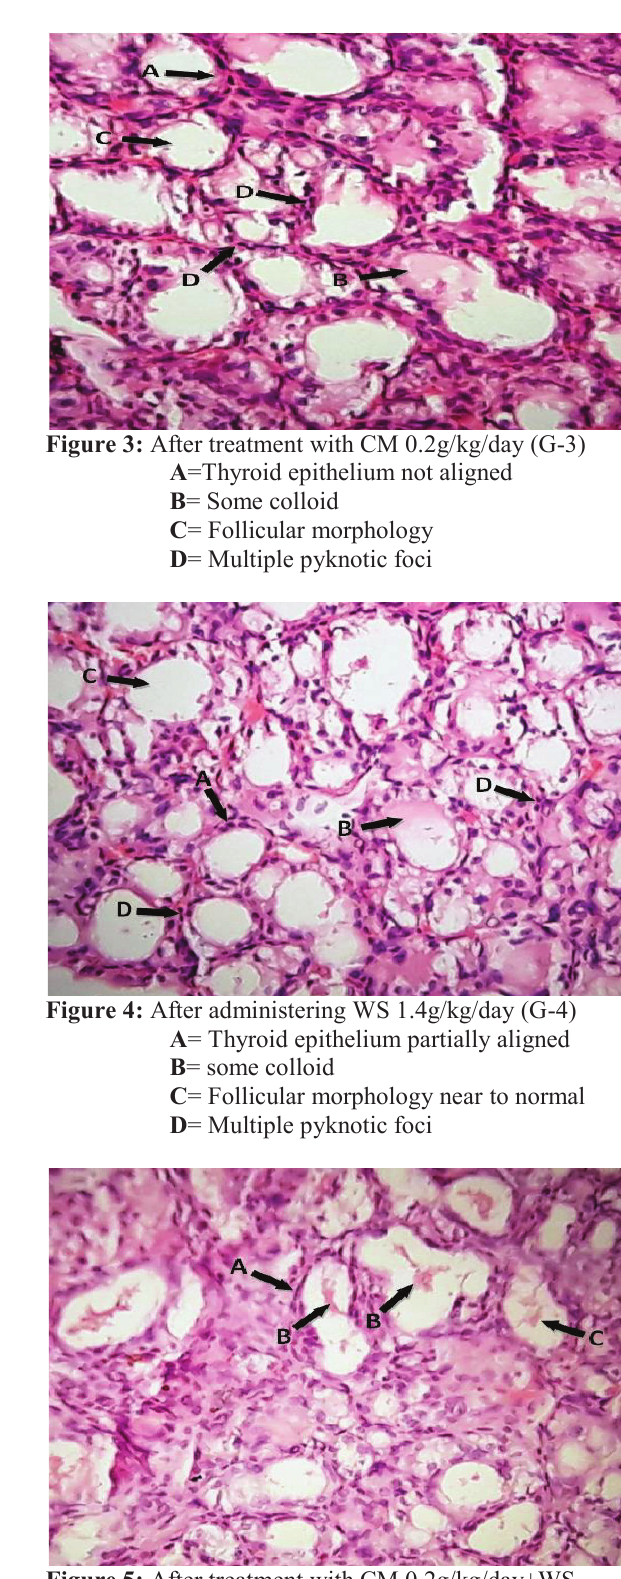
Figure 5: After treatment with CM